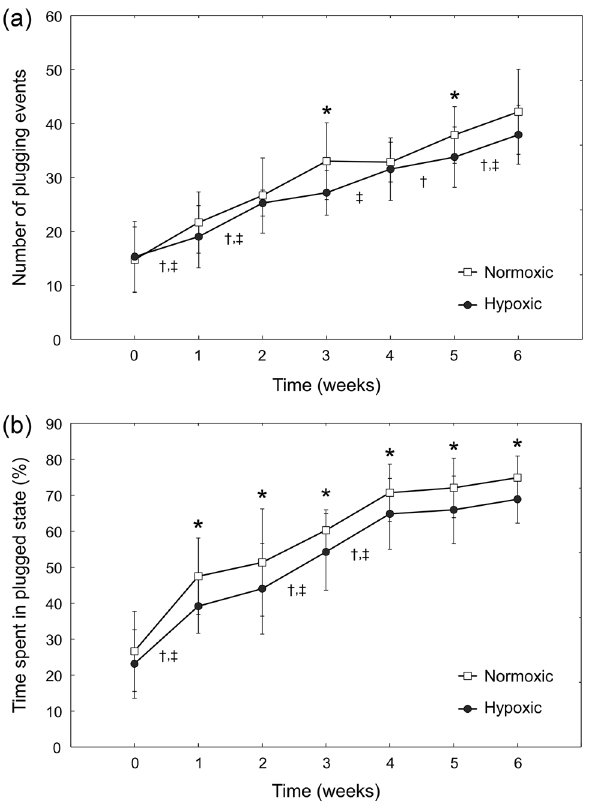
Figure 4. Intermittent plugging of individual MMCN microcapillaries by RBCs stored under normoxic and hypoxic storage conditions. ( a ) Number of ‘plugging’ events; a ‘plugging’ event was defined as a decrease in microcapillary RBC velocity below a baseline value (baseline velocity = mean RBC velocity on week 0—two standard deviations). ( b ) Total percent of observation time all MMCN microcapillaries spent in a plugged state (i.e. percent of time microcapillaries operated below baseline velocity). Values shown are mean ± standard deviation (n = 9 RBC units). Statistically significant differences ( p < 0.05) between normoxic and hypoxic storage of the same duration are marked by an asterisk (*). Statistically significant differences ( p < 0.05) between subsequent weeks of storage are marked by a dagger (†) for normoxic, and a double dagger (‡) for hypoxic